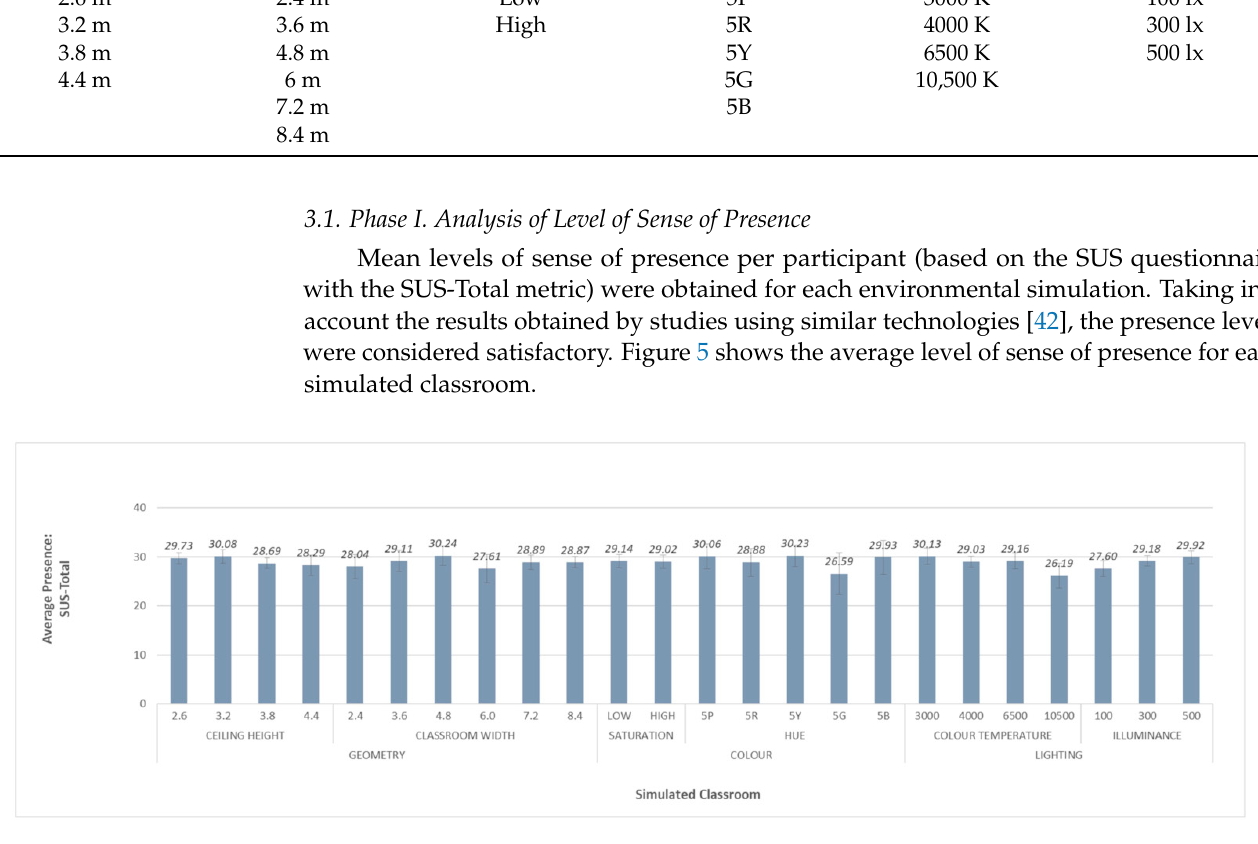
Figure 5. Average level of presence for each simulated classroom.